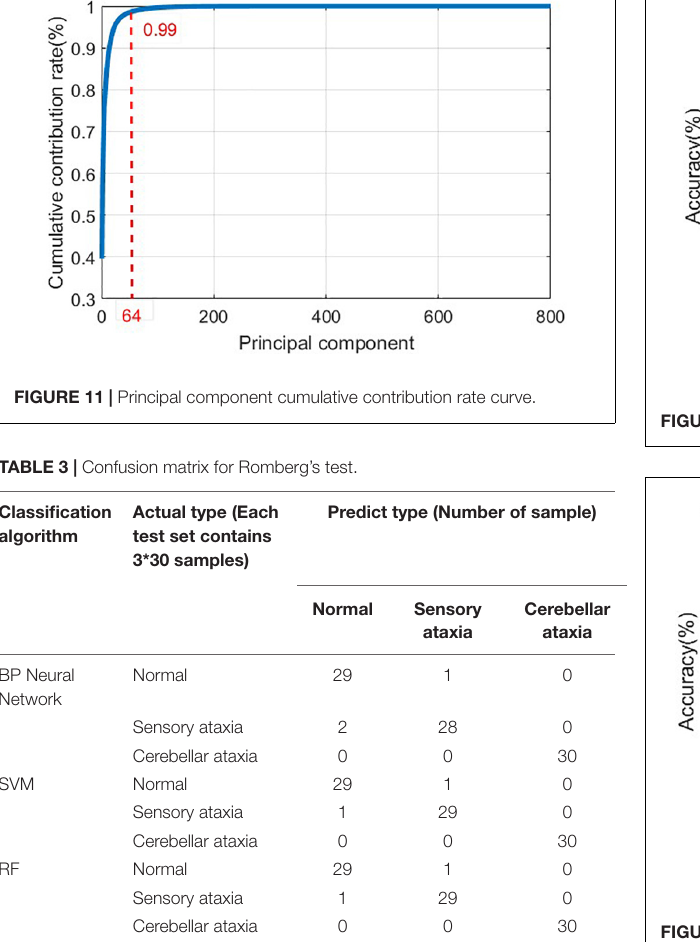
FIGURE 13 | Accuracy of three algorithms in gait